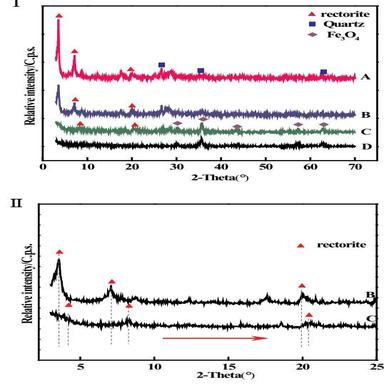
XRD patterns of the samples.